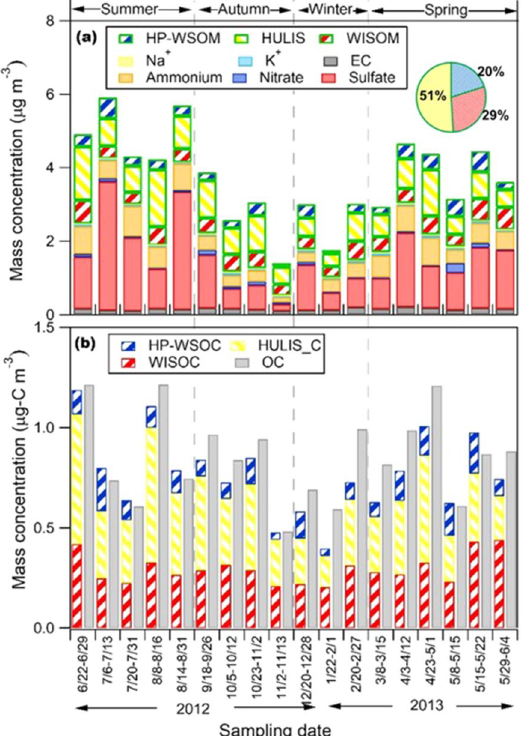
Figure 1. ( a ) Concentrations of extracted organic fractions (WISOM, HULIS, and HP-WSOM) and inorganic components in PM 0.95 over TOEF. The pie chart represents the mean mass percentages of the relative contribution of the fractions. ( b ) Concentrations of organic carbon in the extracted fractions and total organic carbon in PM 0.95 . The format of the sampling date is start month/date to end